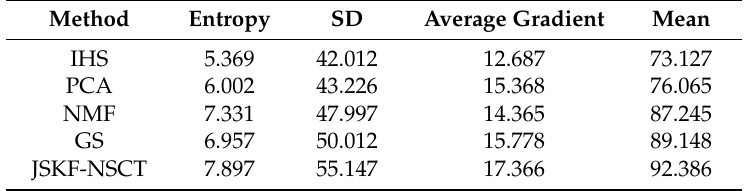
Table 8. Comparison of evaluation for five fusion methods for experiment D.